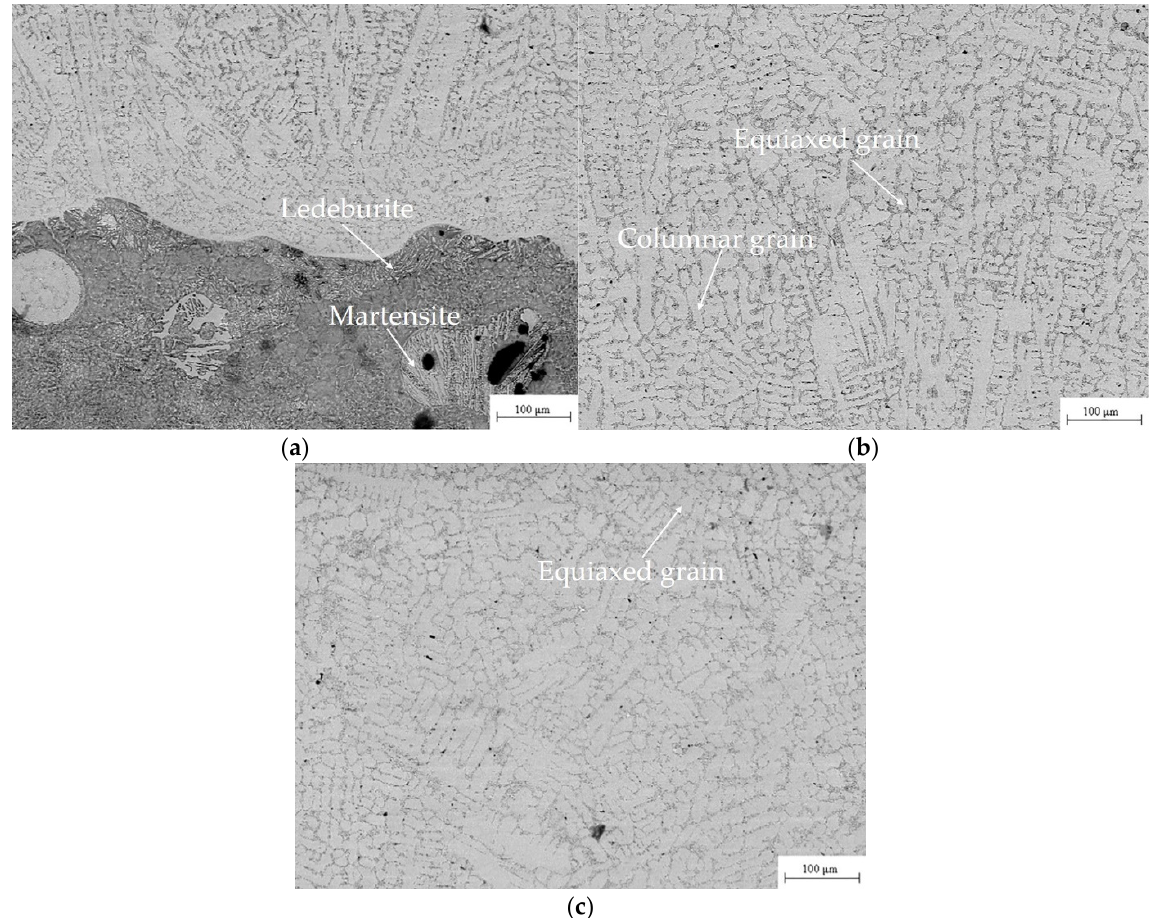
Figure 4. Cross-sectional microstructure of CoCrFeNiMn coating at 60 A plasma arc current: ( a ) bonding zone, ( b ) middle part of the coating, ( c ) top zone of the coating.